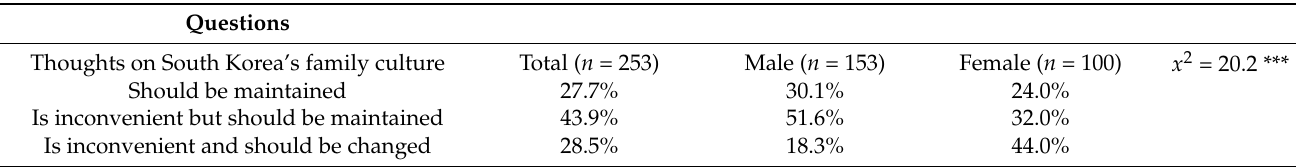
Table 4. ANOVA on cohabitants’ values by sex and by their view on cohabitation as a stage to marriage or an alternative to marriage ( n = 253).